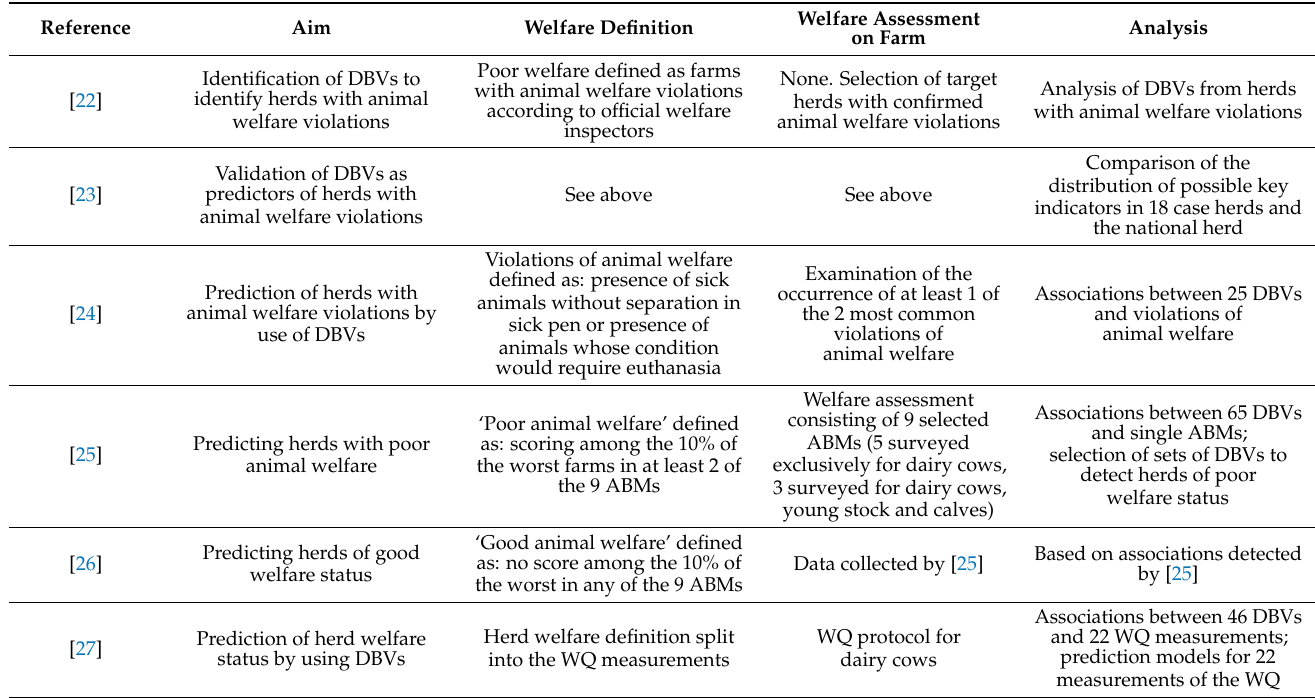
Table 2. Overview of 13 studies identified with the literature